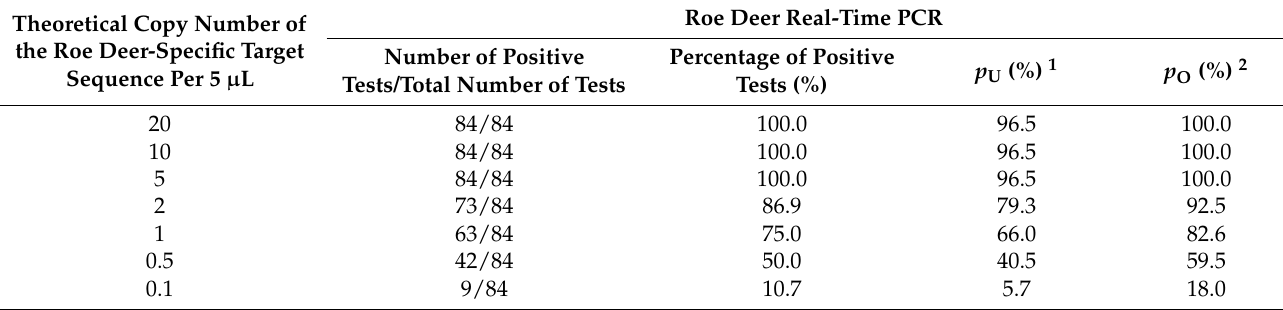
Table 5. Summary of results obtained for determination of LOD 95% of the roe deer real-time PCR assay. Theoretical Copy Number of the Roe Deer-Specific Target Sequence Per 5 µ